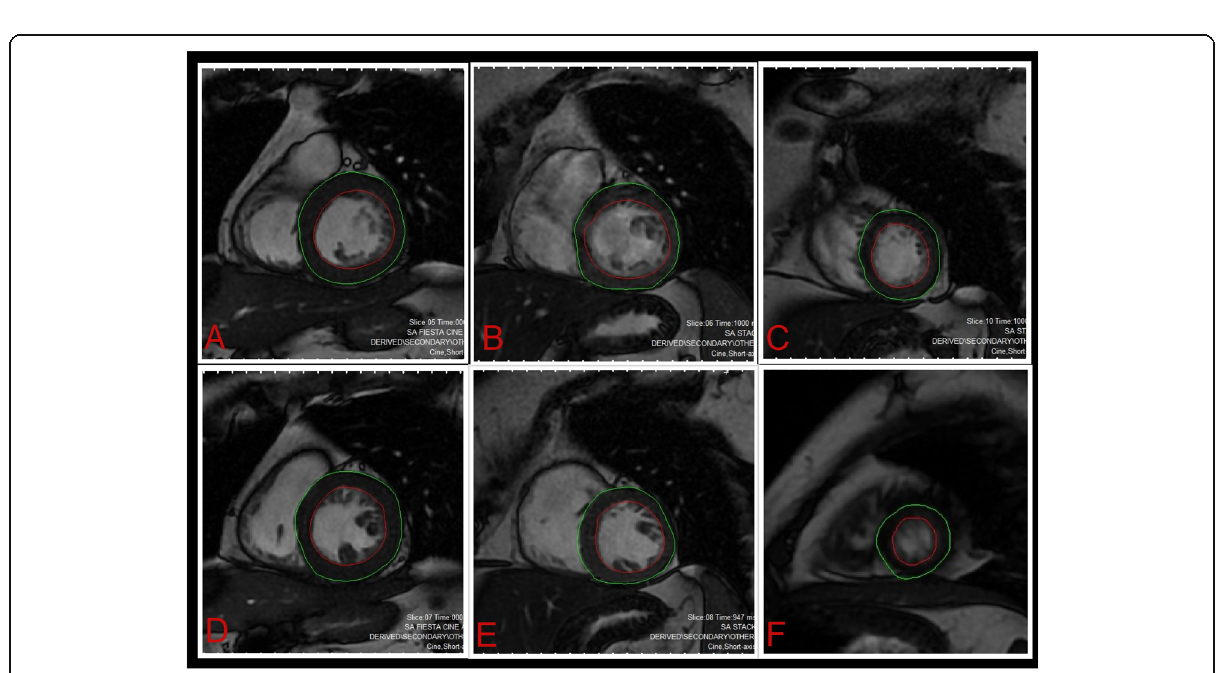
Fig. 7 Represent LV functional post-processing for the SSFP cine images taken for the previous patient; the endocardial (red) and epicardial borders (green) are manually delineated to obtain LV volumes, mass, and EF. a – c Basal, mid, and apical cuts at the baseline scan, calculated EF% was 56%. d - f Basal, mid, and apical cuts for the same patient acquired at the follow-up scan, calculated EF% was